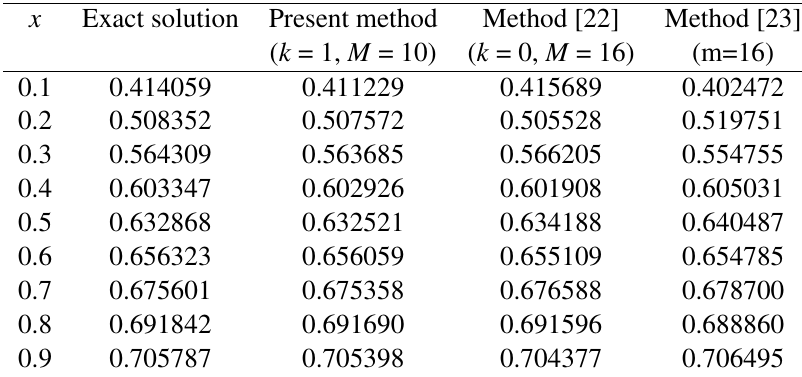
Table 6 Numerical results of example